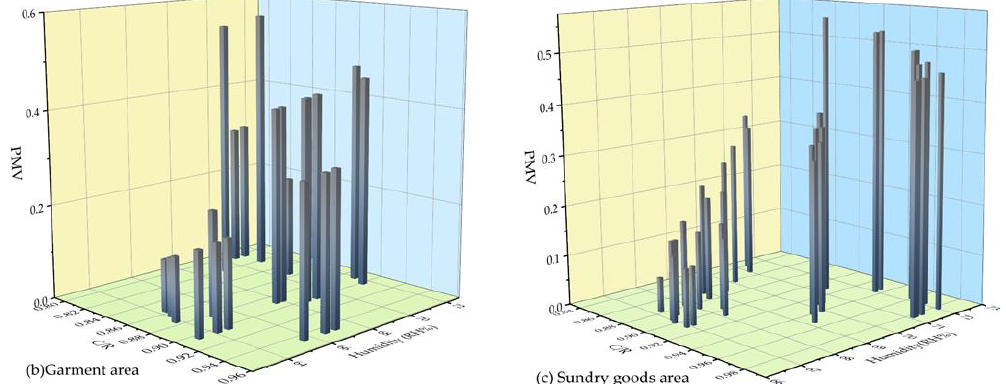
Figure 16. C/R and thermal comfort in catering area ( a ), garment area ( b ) and sundry goods area ( c ).